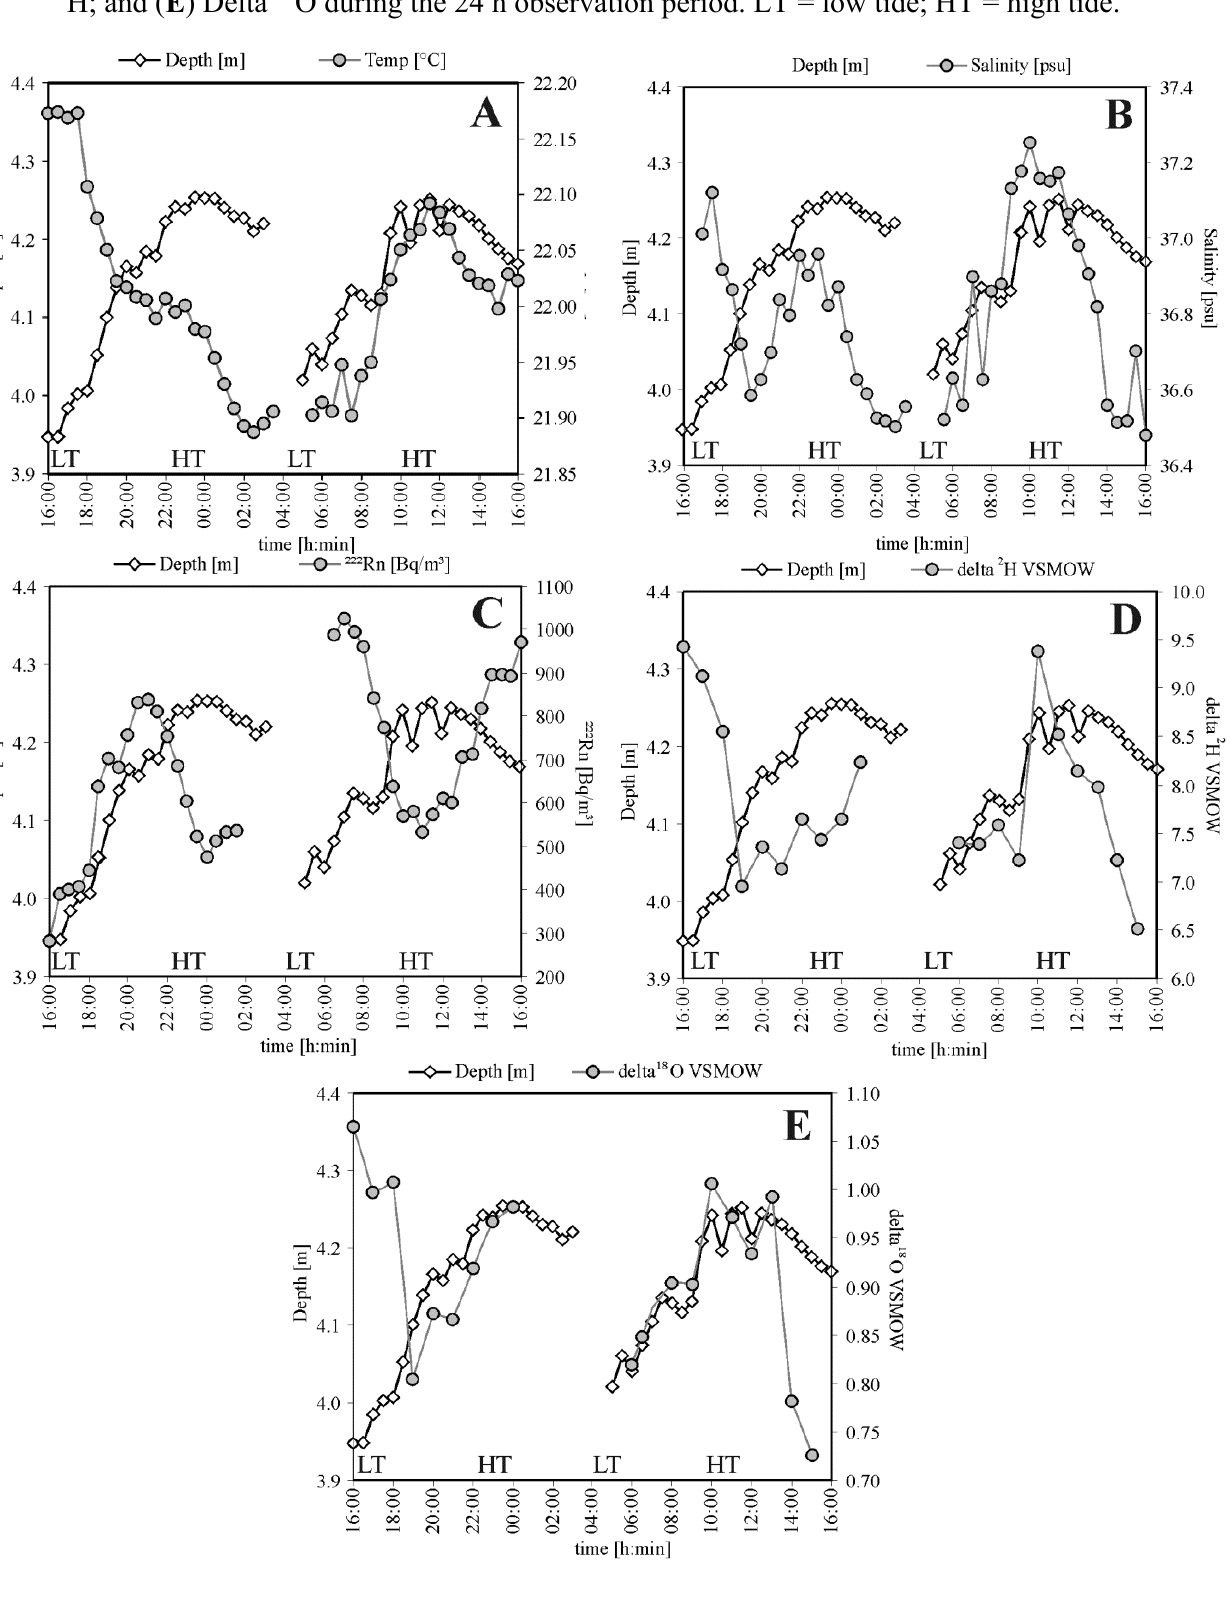
Figure 5. ( A ) Water depth and temperature; ( B ) Salinity; ( C ) Radon concentration; ( D ) Delta 2 H; and ( E ) Delta 18 O during the 24 h observation period. LT = low tide; HT = high